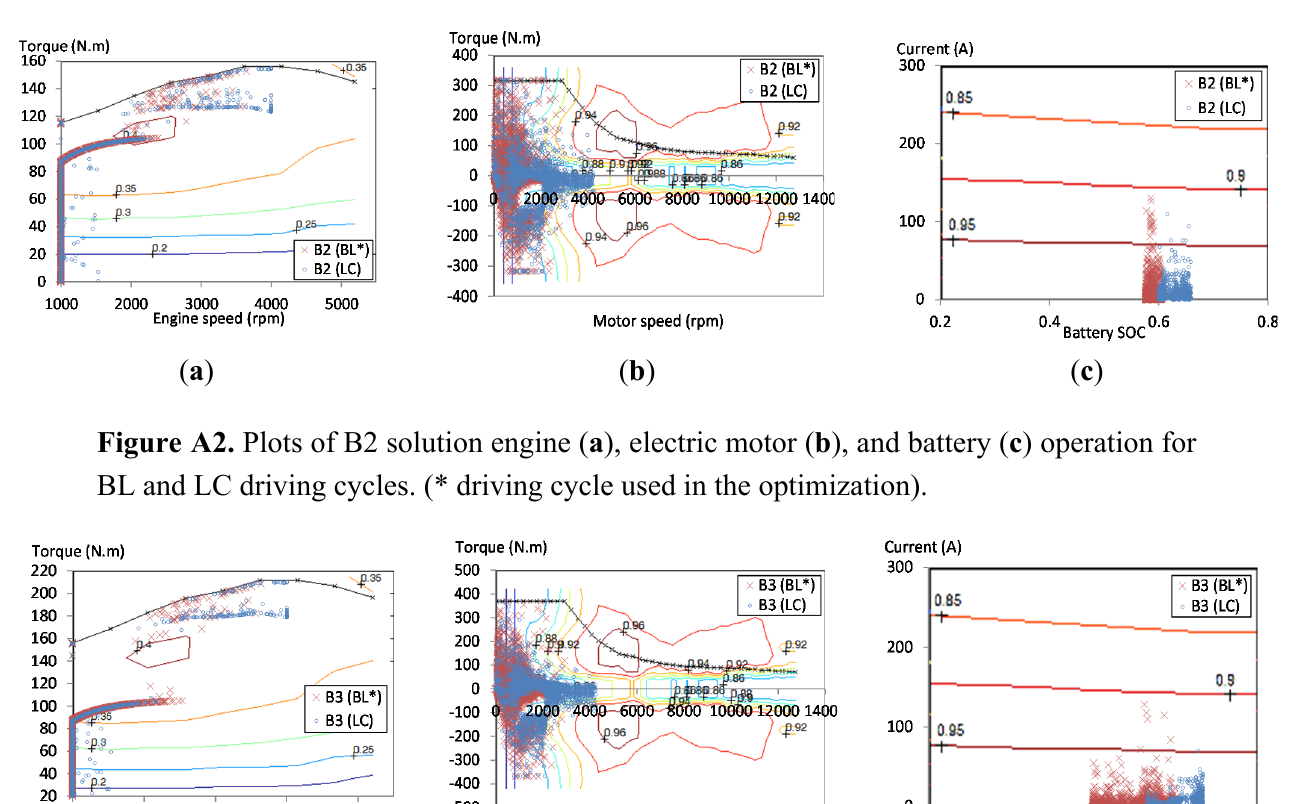
Figure A1. Plots of B1 solution engine ( a ), electric motor ( b ), and battery ( c ) operation for BL and LC driving cycles. (* driving cycle used in the optimization).